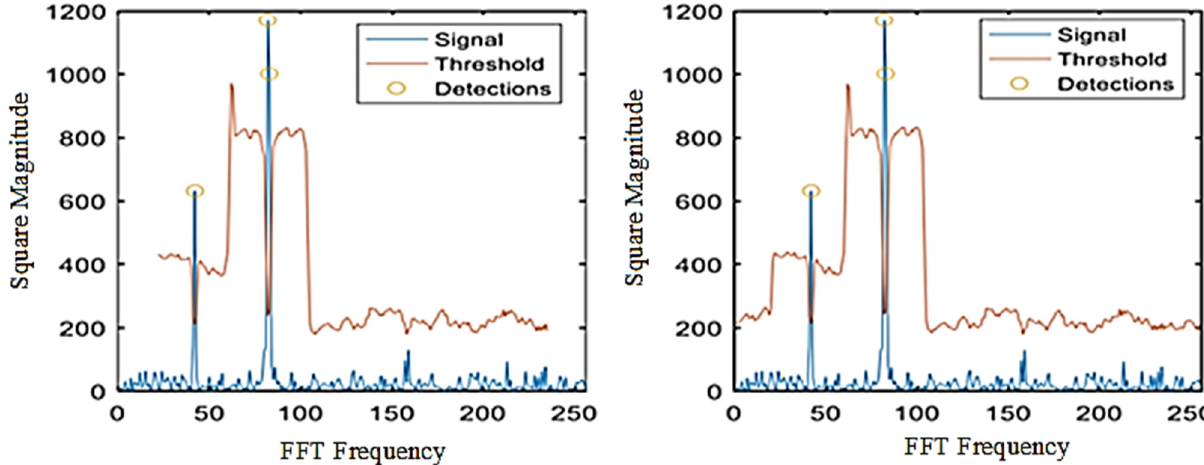
Figure 13. Comparison of the effect of threshold detection.